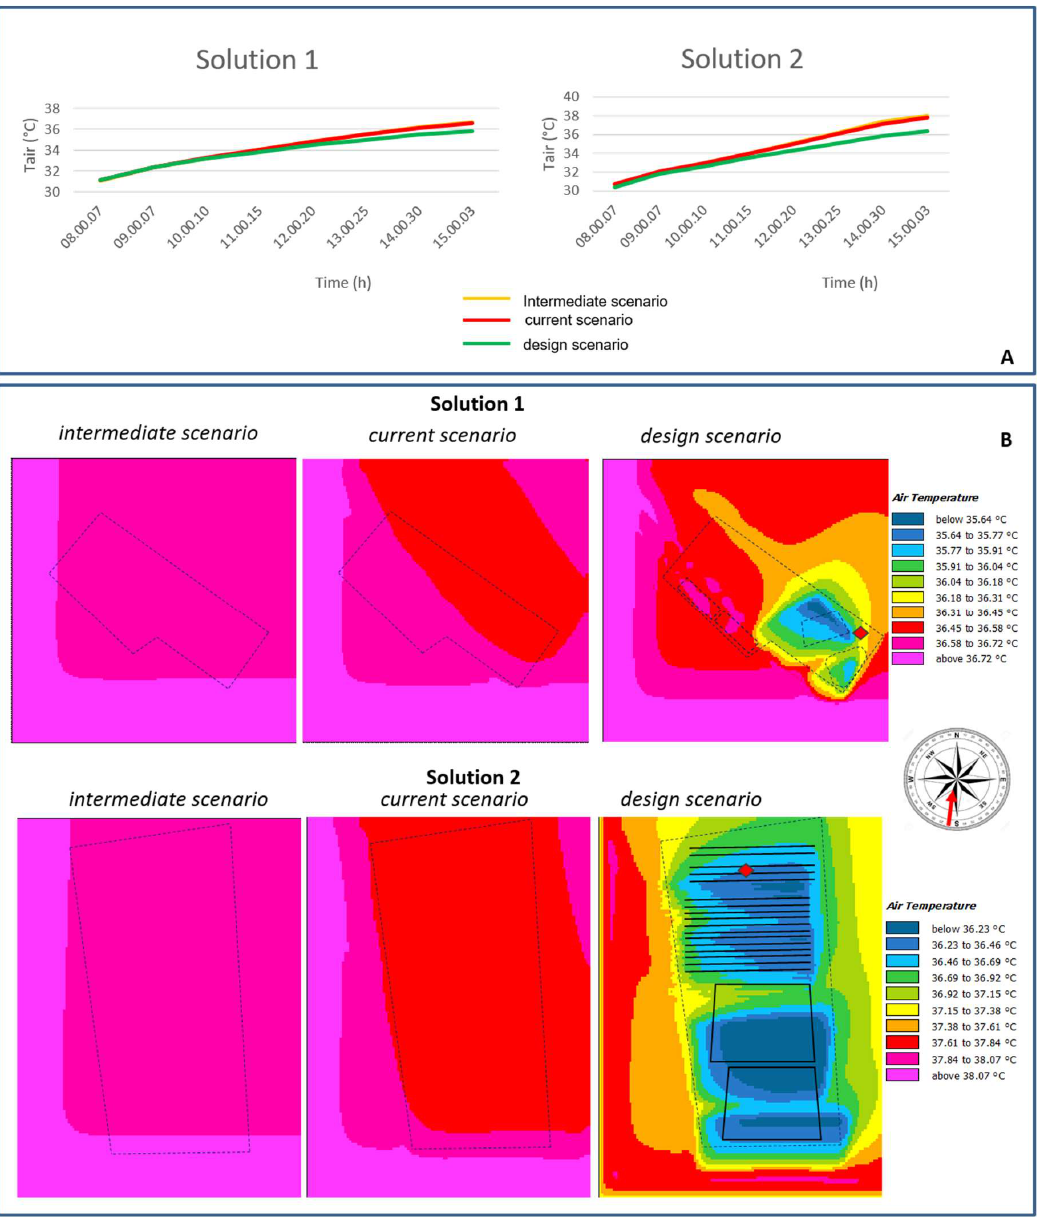
Figure 9. Temporal profile and contours at 15:00 of air temperature (Tair) obtained from ENVI-met Figure 9. Simulation of temperature regulation considering CTW scenarios reported in Figure 8: simulations for Solutions 1 and 2 under different scenarios. ( A ) Air temperature (Tair) hourly profiles for solution 1 and solution 2; ( B ) Spatial characterization of air temperature (Tair) at 15:00 for solution 1 and solution